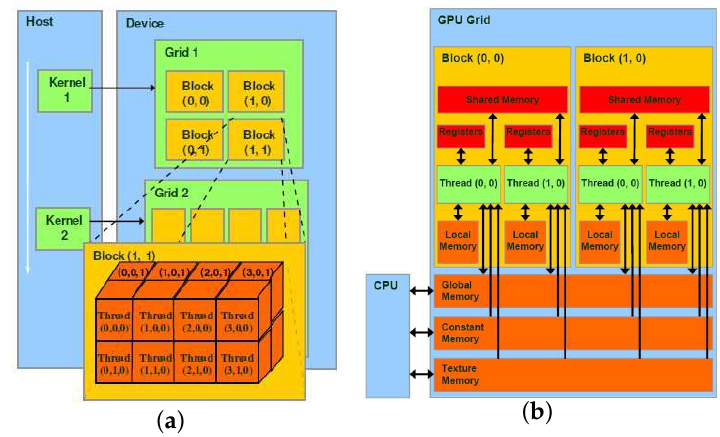
Figure 4. Compute Unified Device Architecture (CUDA) parallel computing: ( a ) its execution model. ( b ) memory hierarchy [28].